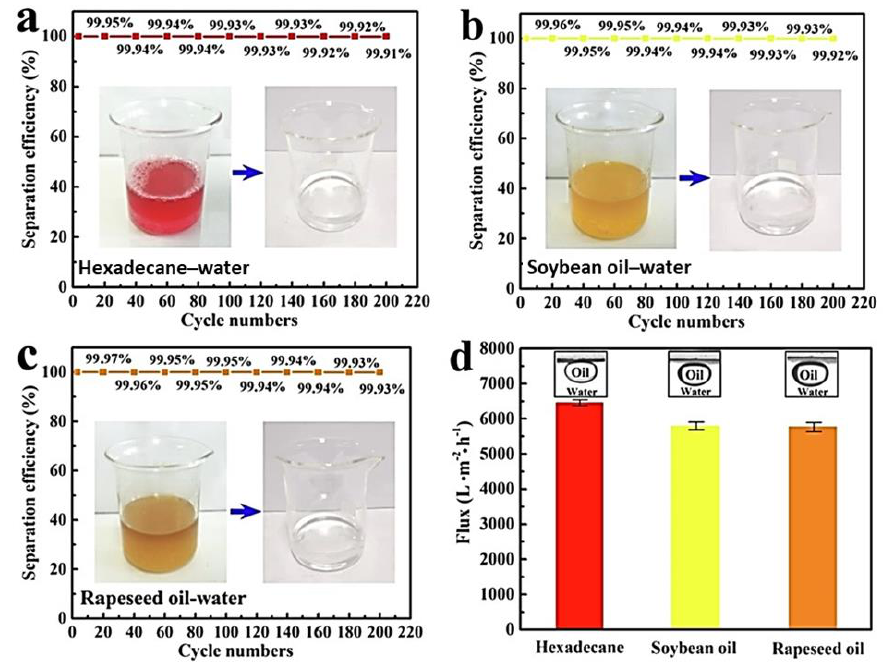
Figure 10. Separation efficiencies of CuO@PAA membrane for various oil–water combinations ( a – c ) and water penetration fluxes ( d ). Insets 10a, b, and c show oil–water combinations and filtered water; 5d shows hexadecane, soybean oil, and rapeseed oil on CuO@PAA membrane in water [139]. Re-